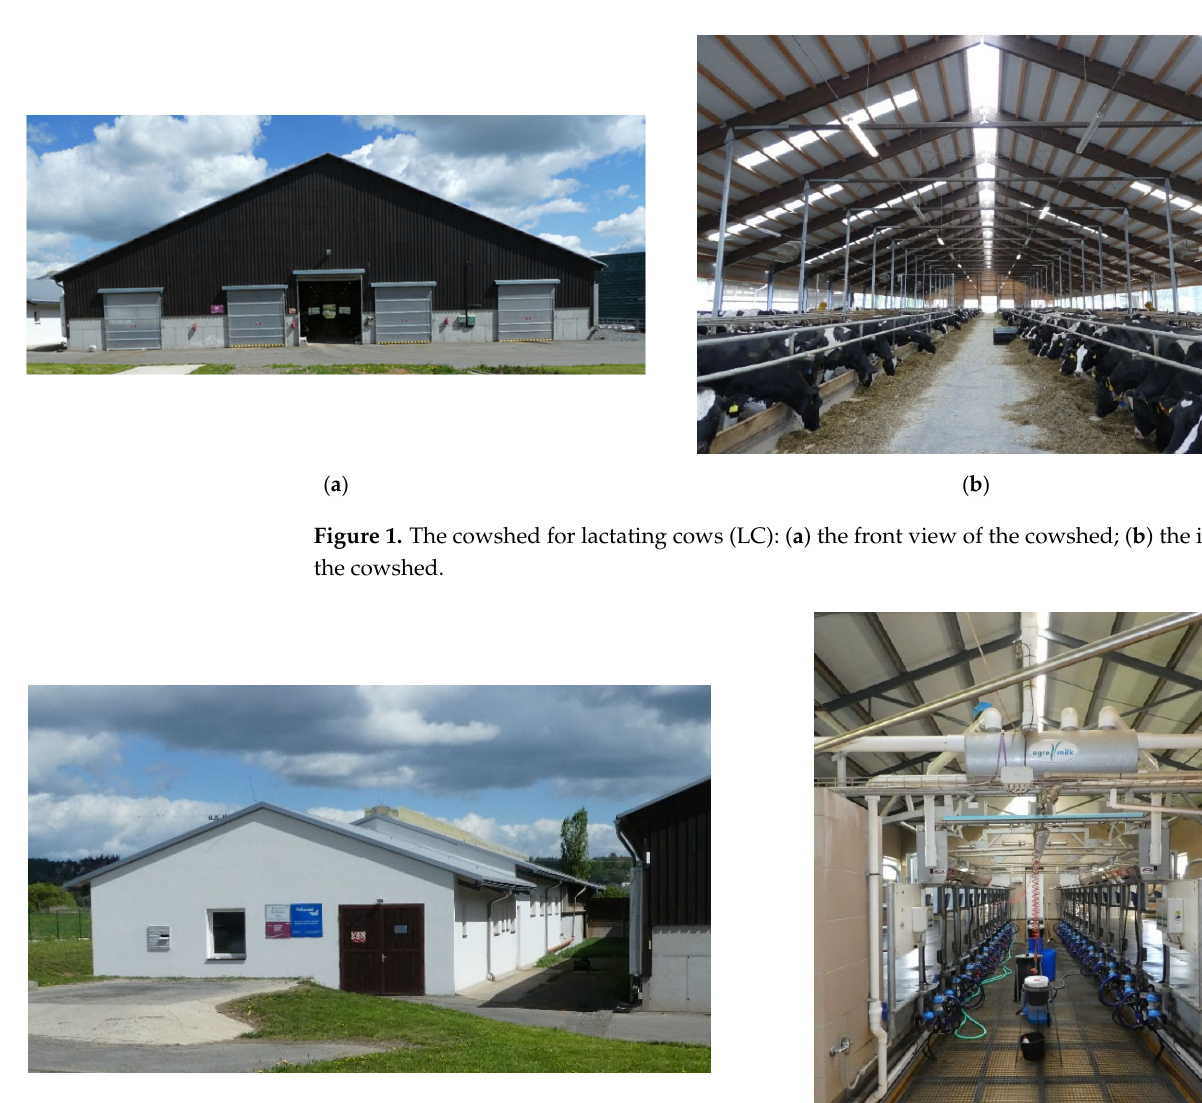
Figure 1. The cowshed for lactating cows (LC): ( a ) the front view of the cowshed; ( b ) the interior of the cowshed.